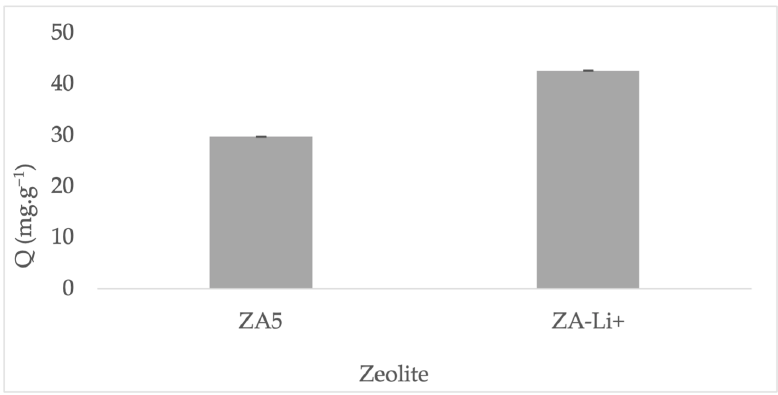
Figure 11. Methylene blue adsorption performance comparison between ZA5 and ZA-Li + .